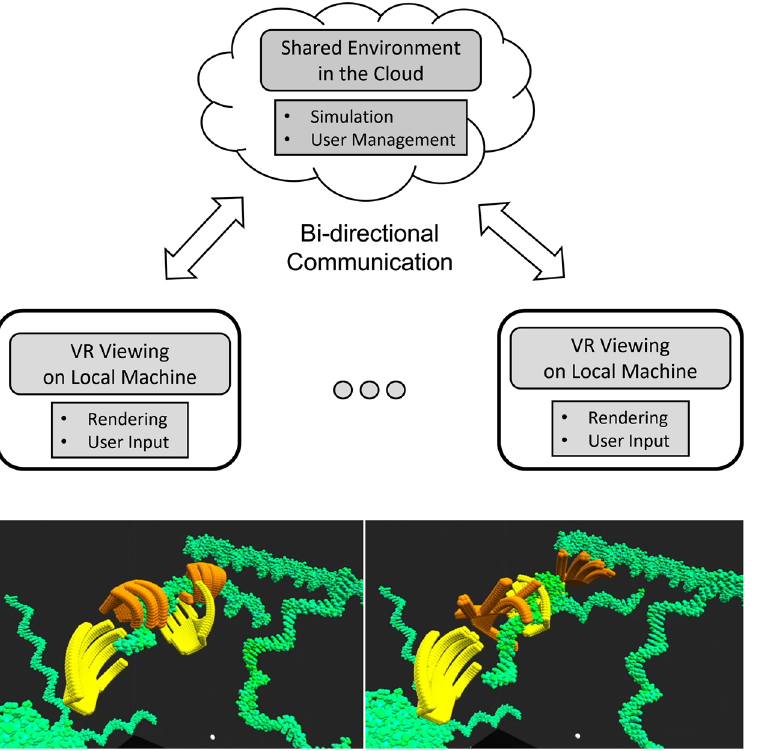
Figure 7: Snapshots from a video of two users passing a DNA strand